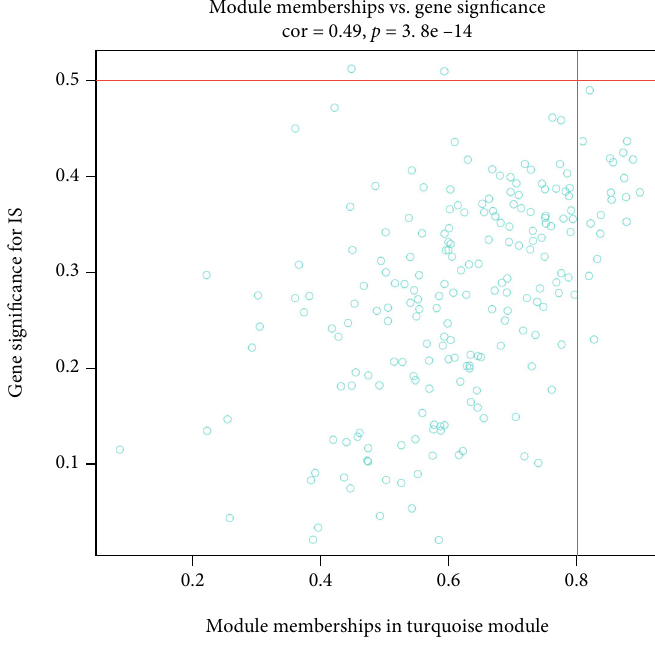
Figure 3: Identi fi cation of modules associated with clinical characteristics of IS females. (a) Cluster tree diagram and module feature relationship diagram for hierarchical cluster analysis to detect co-expression clustering with the corresponding color distribution. Each color represented a module in the gene co-expression network constructed by WGCNA. Heat map of the correlation between the module. (b) Characteristic gene in IS female samples and normal samples. ((c) and (d)) The relationship between the scatter plot of the members of the module and the genetic importance of morbid